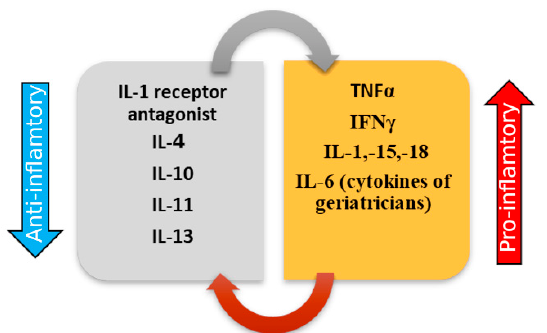
(TNF α ), interferon γ (IFN γ ), and interleukins (IL)—IL-1, IL-6, IL, IL-15, and IL-18 [5]. IL-6 can be considered a predictive marker of inflammaging, being called the cytokine of geriatricians. The polymorphisms in the promoter C/G 174 on the IL-6 gene is related to immune-inflammatory responses and affects serum IL-6 concentrations.